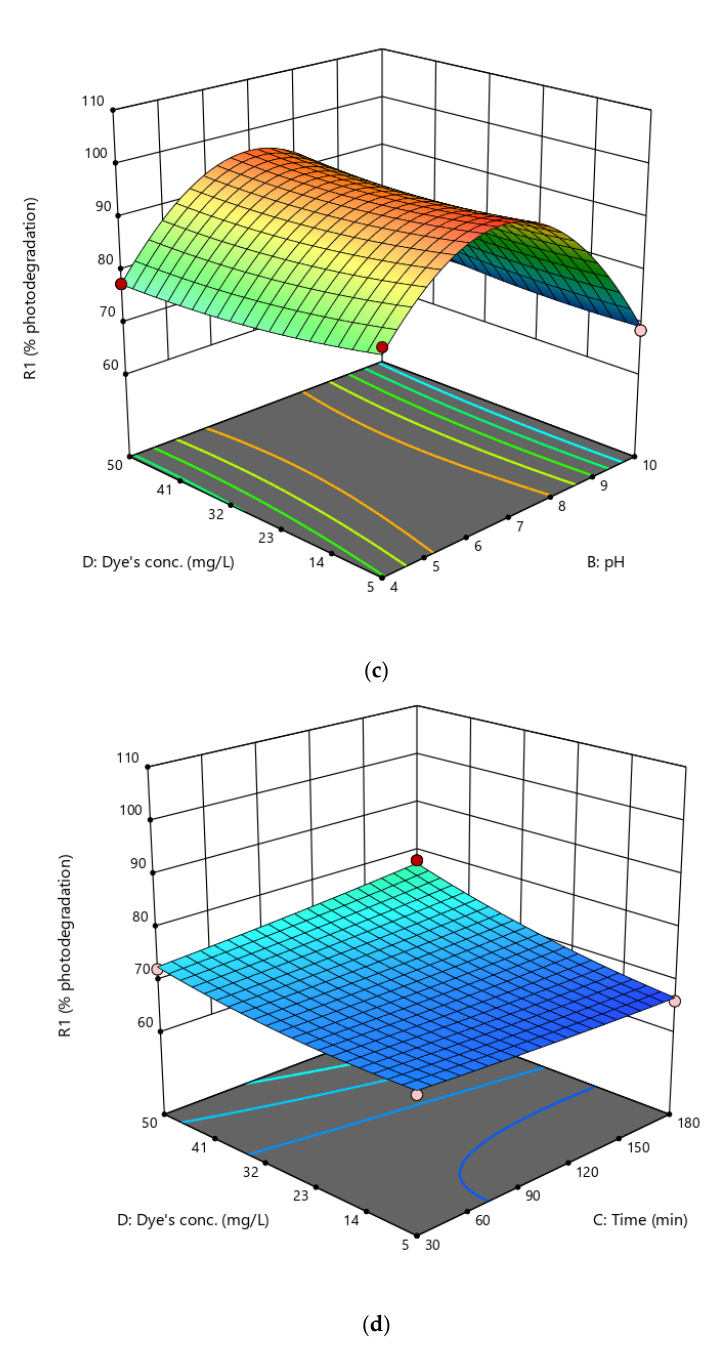
Figure 8. 3D surface plots representing the relationship between different variables ( a ) pH, catalyst dose ( b ) time, pH ( c ) Dye’s conc., ( d ) Dye’s conc., time, and percentage photodegradation in case of congo red dye.